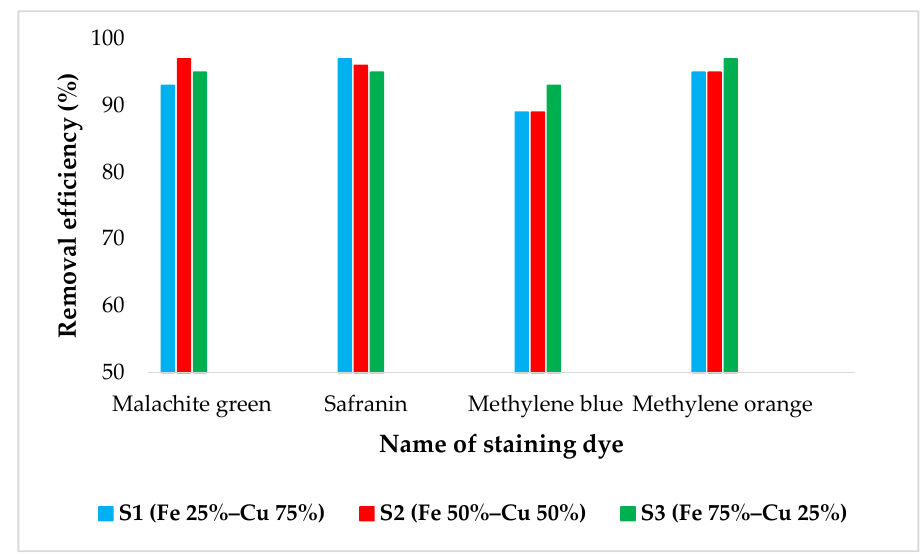
Figure 7. Removal e ffi ciency of dyes by nanoparticle samples S1, S2, and S3. Figure 7. Removal efficiency of dyes by nanoparticle samples S1, S2, and S3.